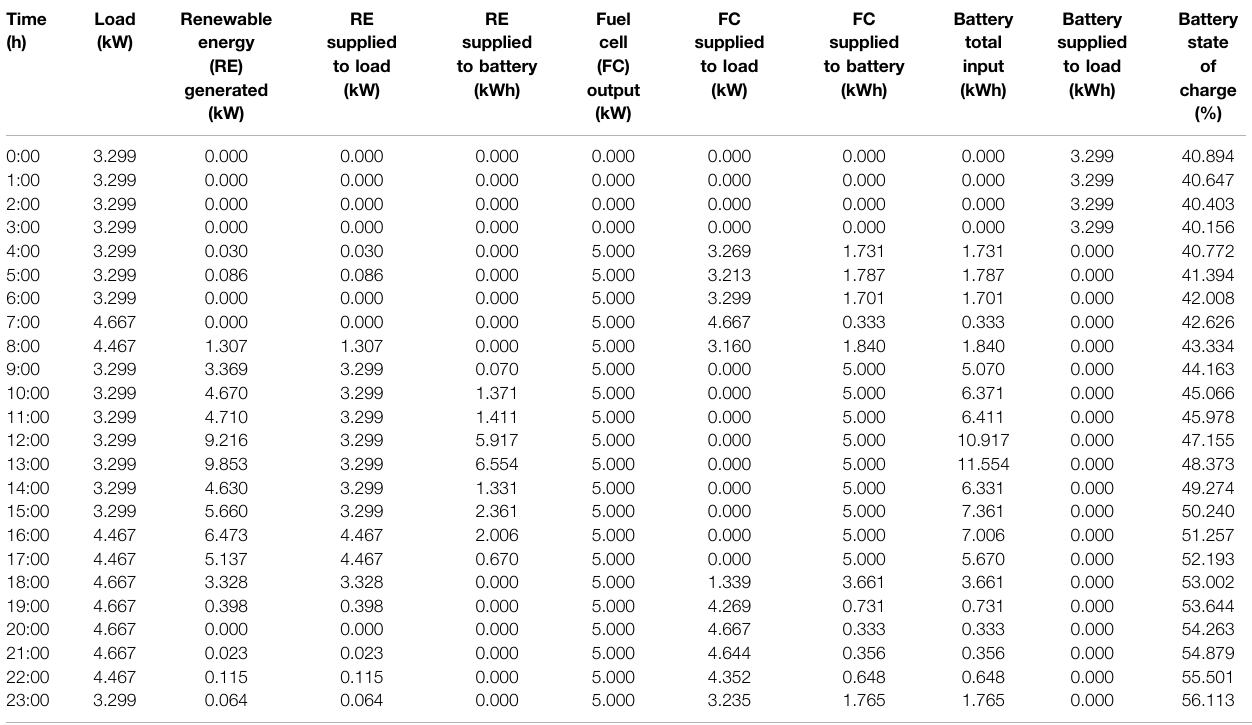
TABLE 1 | Power demand met by the integrated renewable energy system (PV and wind) in day one. Time Load Renewable (h) (kW)